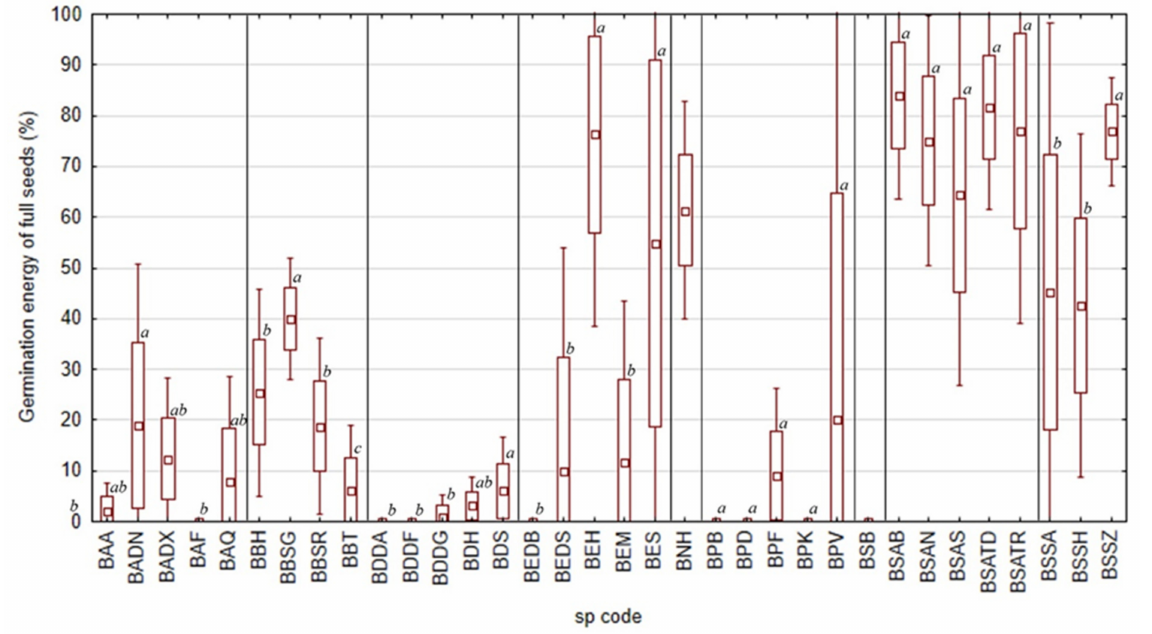
Figure 5. Seed germination energy of full seeds of all nine taxa of Boswellia from different localities in 2021 (a, b, c—Indexes denoting localities with significantly separate germination rates within individual taxon, the same index associates the seed without statistically significant difference in germination energy of full seeds).